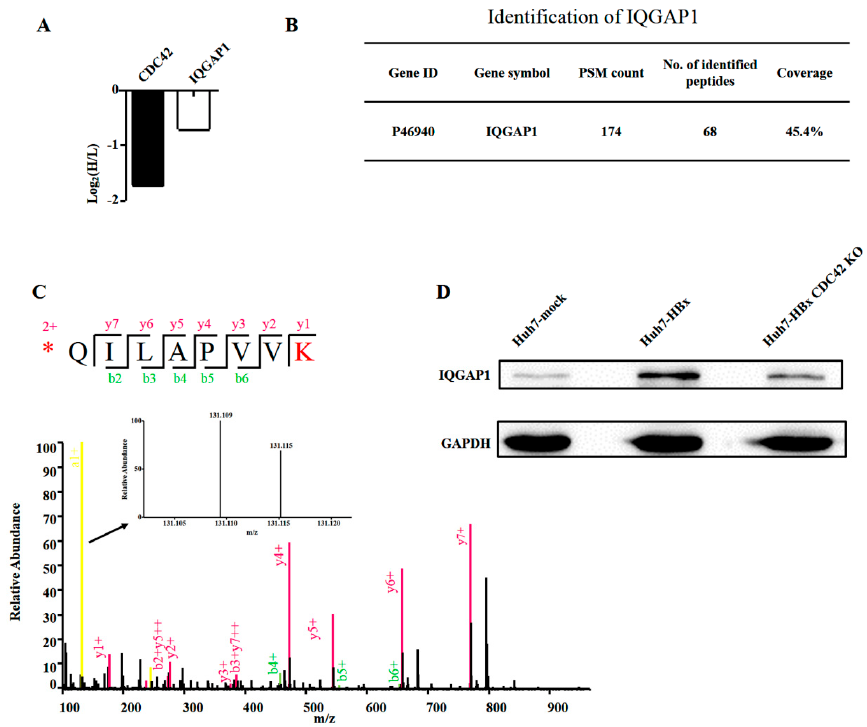
Figure 6. The expression of IQGAP1 was down-regulated when CDC42 was absent. ( A ) Quantitative proteomics data suggested that CDC42 and IQGAP1 were significantly down-regulated in HuH-7-HBx CDC42 KO cells; ( B ) Identification details of IQGAP1; ( C ) Verification of the quantified IQGAP1 by randomly choosing an MS 2 spectrum and comparing the intensity of the a1 ion; ( D ) Western blot assay was performed to detect the expression of IQGAP1 in HuH-7-mock, HuH-7-HBx, and HuH-7-HBx CDC42 KO cells.